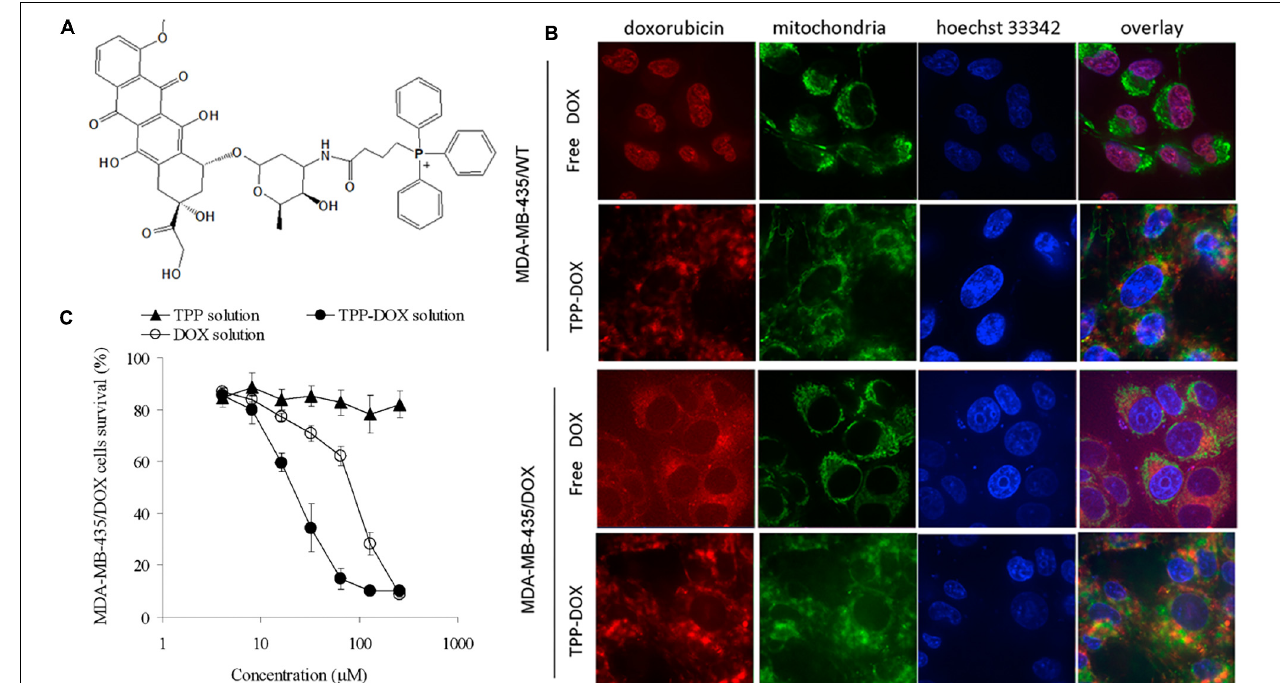
FIGURE 2 | (A) Chemical structure of TPP-DOX. (B) Subcellular localization and (C) cytotoxicity of free DOX and TPP-DOX in drug-sensitive and resistant cancer cells; adapted with permission from reference (Han et al., 2014).